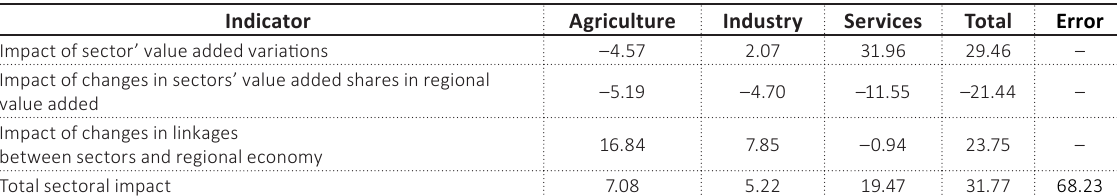
Source: Own calculations.